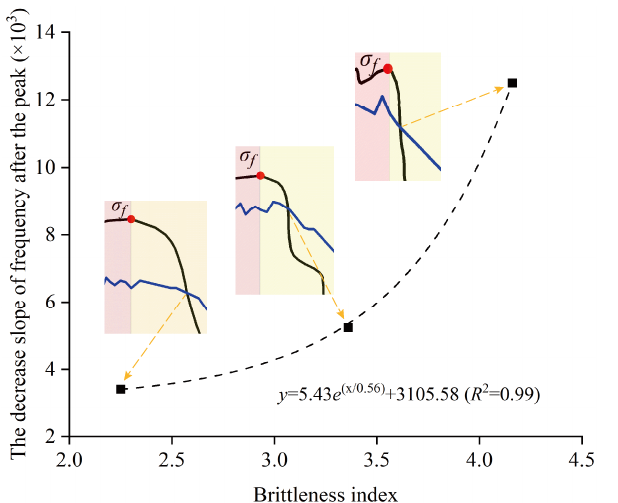
Figure 19. Relationship between the natural frequency decline slope at the stress drop and the brittleness index.